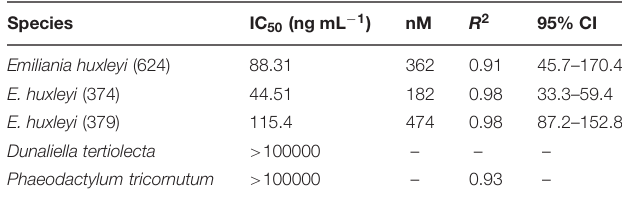
TABLE 2 | Inhibitory concentration (IC 50 ) of HHQ isolated from Pseudoalteromonas piscicida in five different strains of phytoplankton.